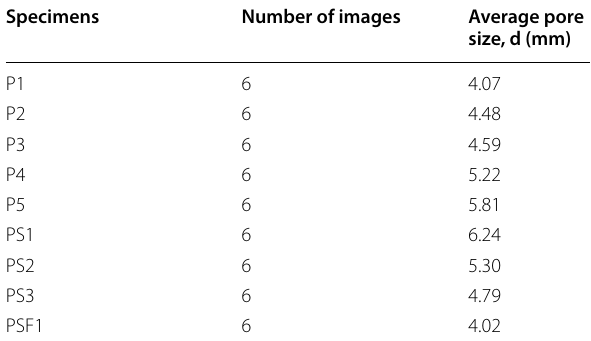
Table 6 Average pore sizes of different mix